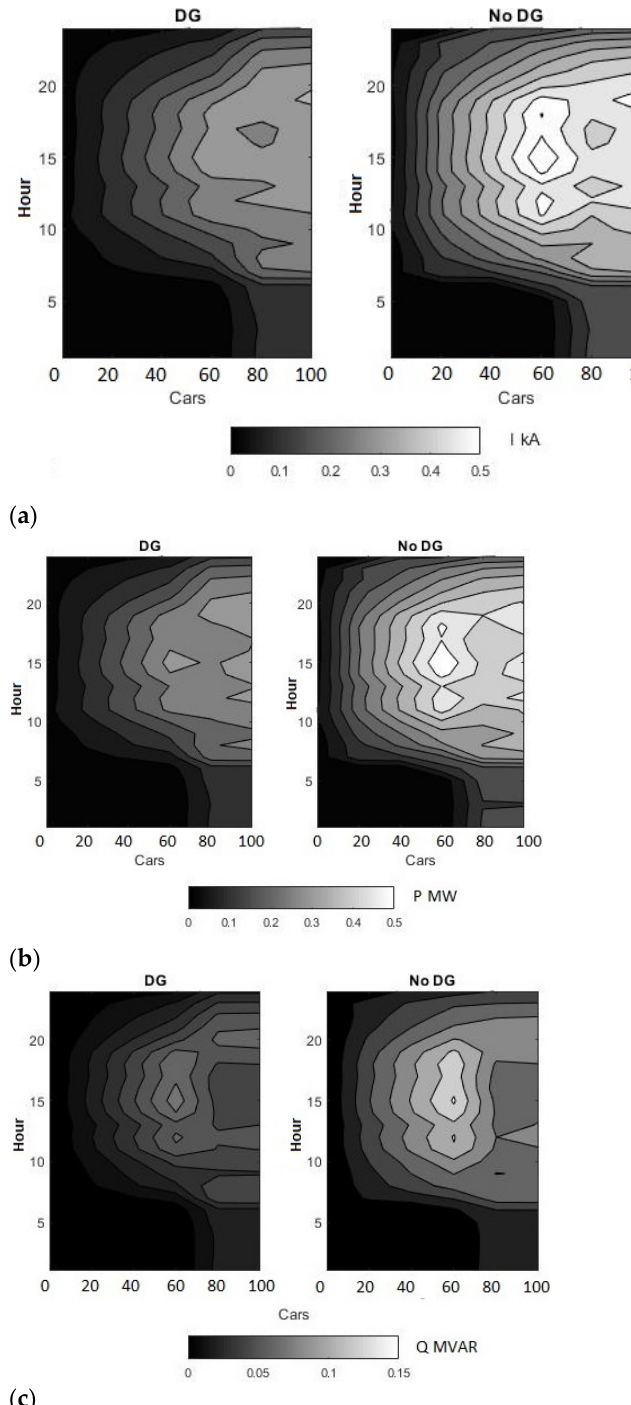
Figure 12. ( a ) Maximum current drawn by the feeder. ( b ) Peak active power requirements of the network. ( c ) Peak reactive power requirements of the network versus EV penetration.